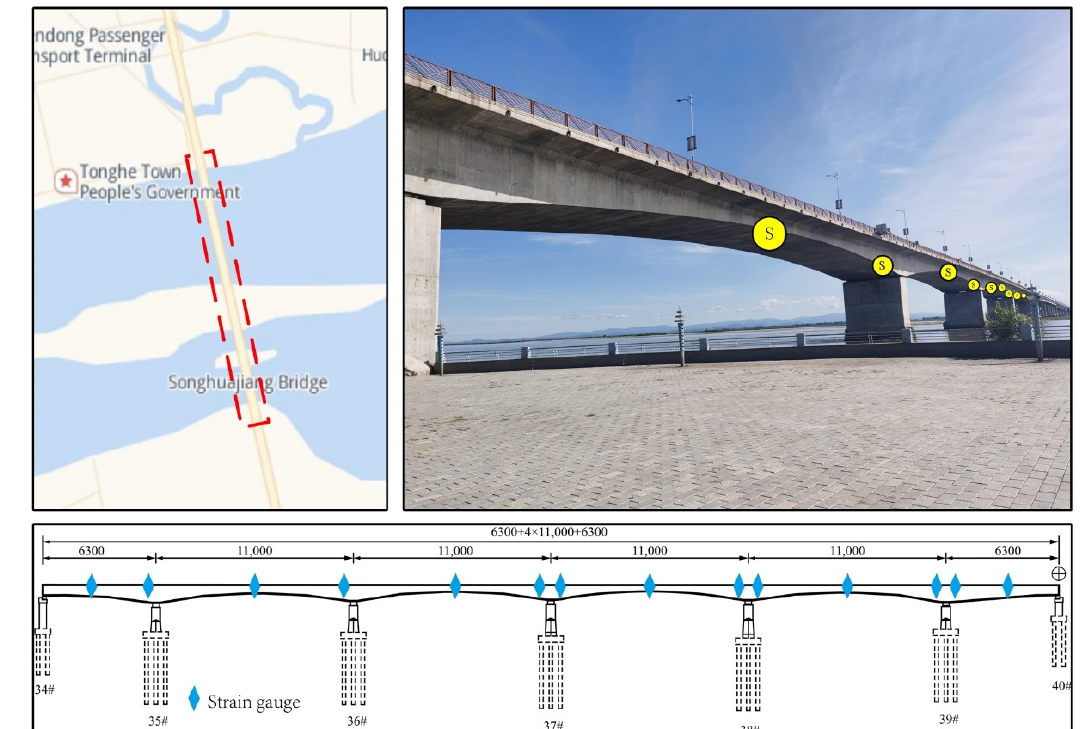
Figure 3. Location of Songhua River Bridge and sensor layout.